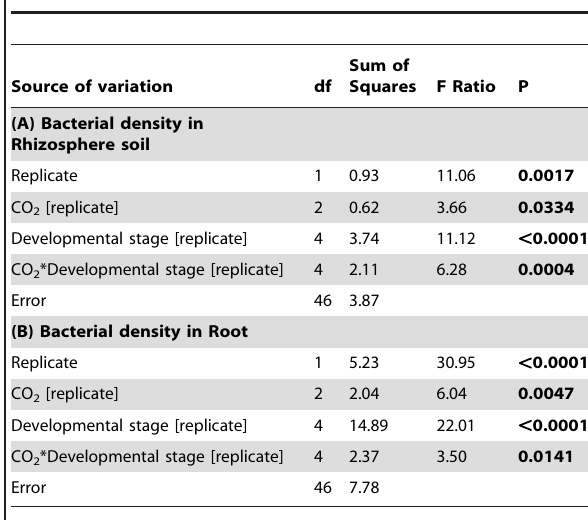
Table 4. ANOVA explaining the density of Pseudomonas fluorescens C7R12 in the rhizosphere soil (A) and the plant roots (B), as a function of CO 2 concentration (ambient, 365 ppm or enriched, 750 ppm), the plant developmental stage (V, Fp and Pf, see text) and the experimental replicate (nested factor).